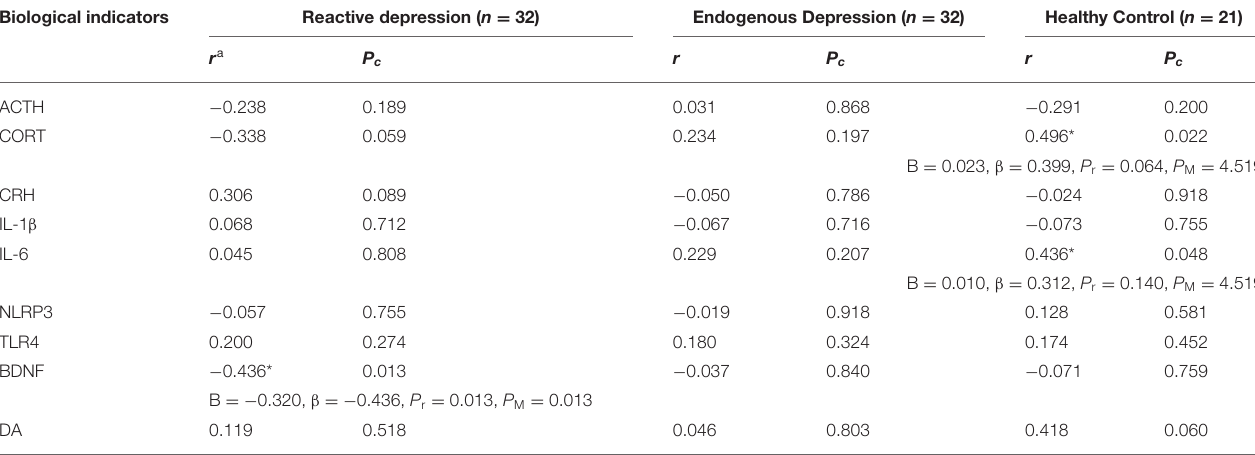
TABLE 3 | Correlations and multivariable regression analyses among serum biological indicators and HAMD-24 total scores in different groups. Biological